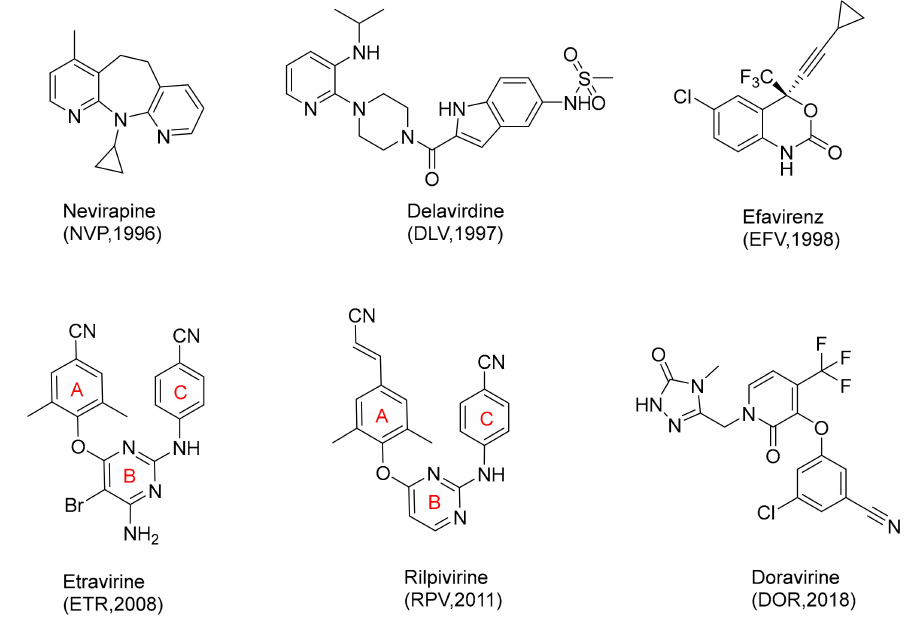
Figure 1. Chemical structures of the FDA-approved nonnucleoside reverse transcriptase inhibitors